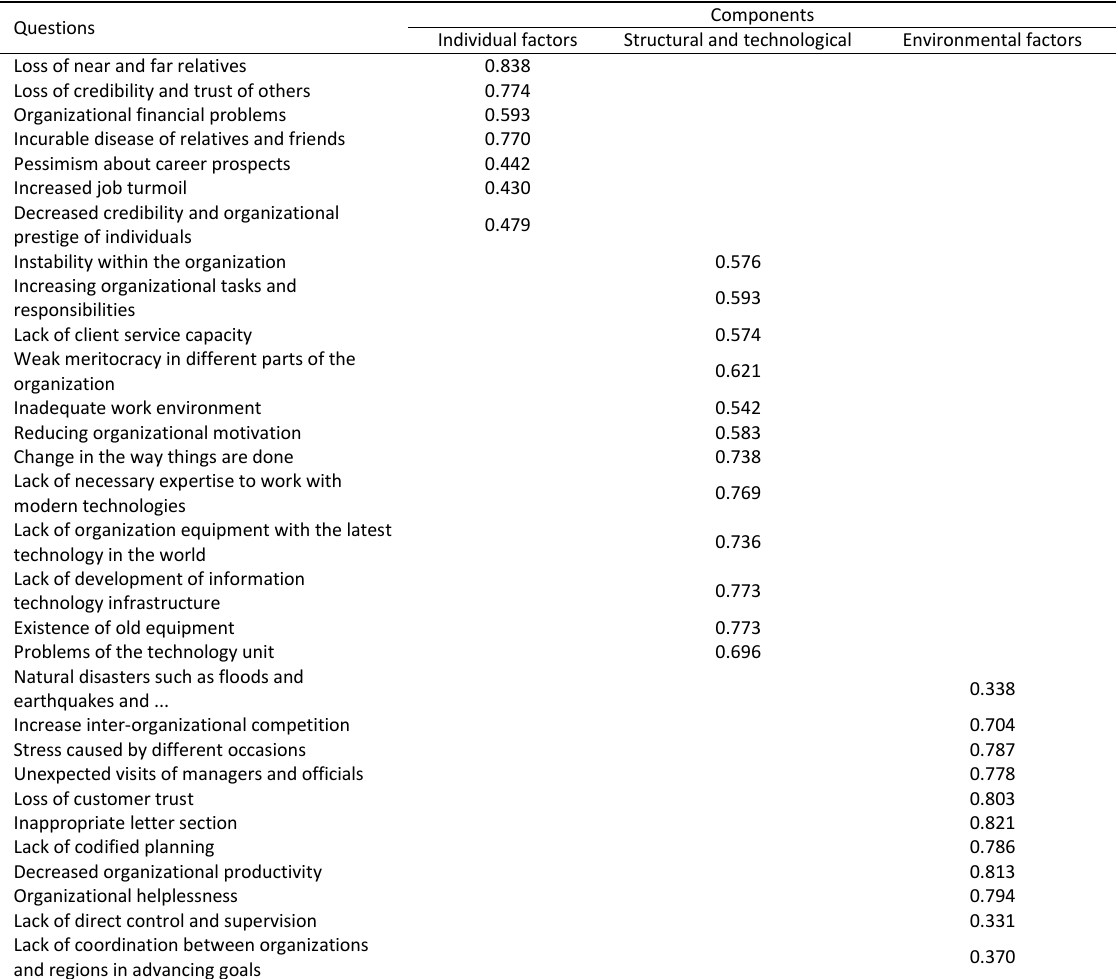
Table 3. Results of the main components with varimax rotation of the operating load of the items of the questionnaires